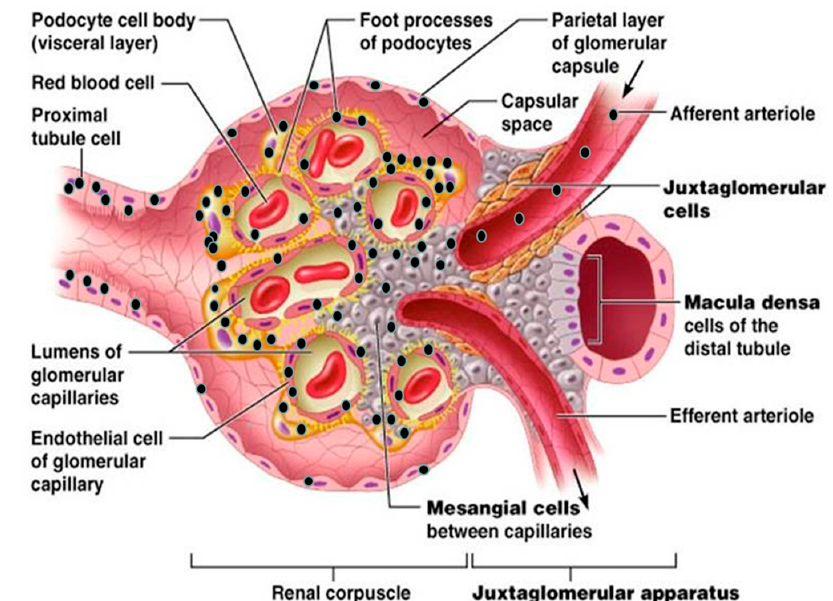
Figure 2. A hypothetical mode for BKV dissemination in the glomerular that includes GVU cells. BKV (black spheres) enters the glomerulus of the renal compartment via the afferent arteriole during the viremic phase of infection. This leads to the initial infection of GVU cells, namely the mesangial cells. Next, the virus spreads from mesangial cells to glomerular podocytes, and then locally to glomerular endothelial cells that are also highly permissive for infection in vitro and reported to be infected by BKV in vivo. The virus then encounters the parietal cells of the glomerular capsule that are reported to be permissive for BKV in vivo. Finally, the virus further disseminates and infects the proximal tubular epithelial cells that are highly permissive for BKV infection in vitro and in vivo. Widespread virus infection and replication in GVU targets cells, along with tubular epithelial cells and parietal glomerular capsular cells, would theoretically contributes to the viruria, viremia, inflammation, and nephropathy. Model of BKV entry and existence in the glomerulus (modified with permission from Pearson Education Inc. 2013 (unpublished data)).